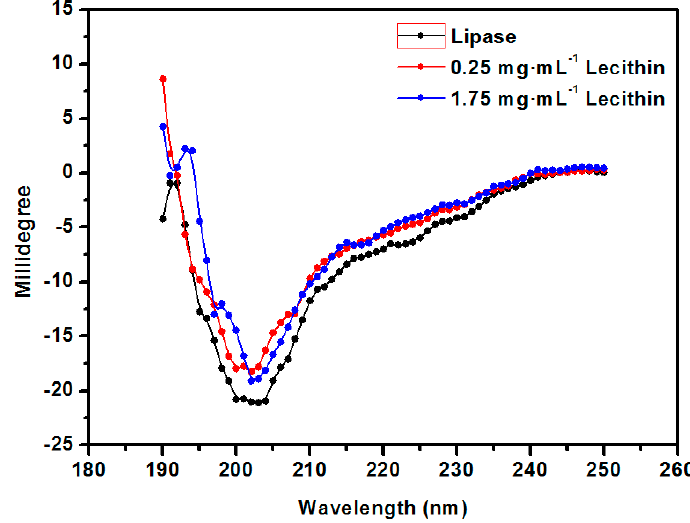
Figure 3. CD spectra of free lipase and lecithin-lipase complexation.